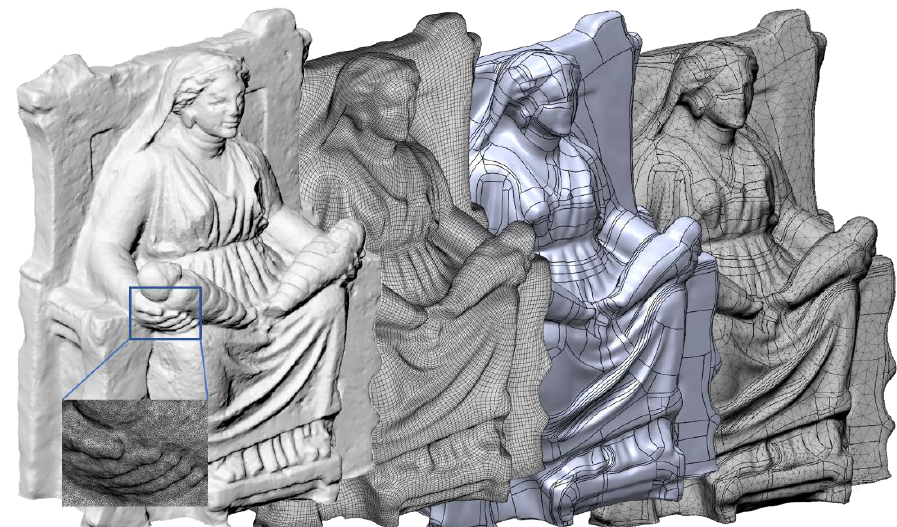
Figure 10. From the very dense scanned and tessellated model to the FE (Finite Element) mesh model, passing through the quad mesh and the surface model (from left to right).